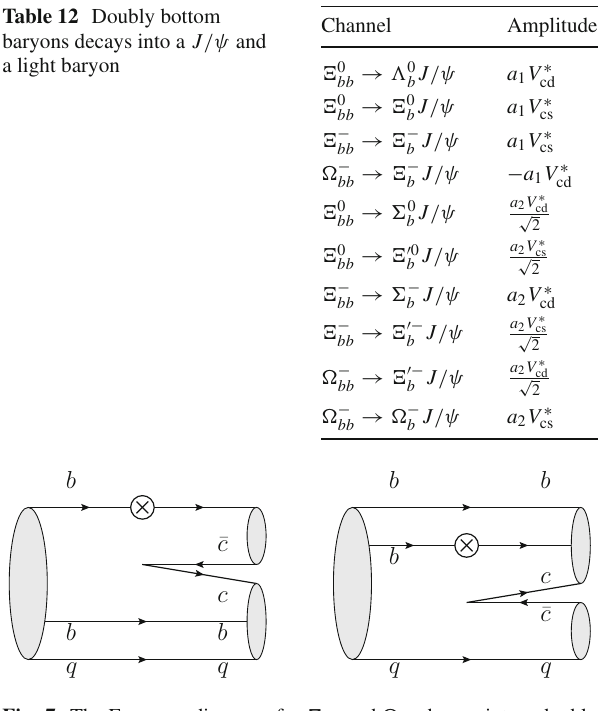
Fig. 7 The Feynman diagrams for (cid:2) bb and (cid:5) bb decays into a doubly heavy baryon and an anticharmed